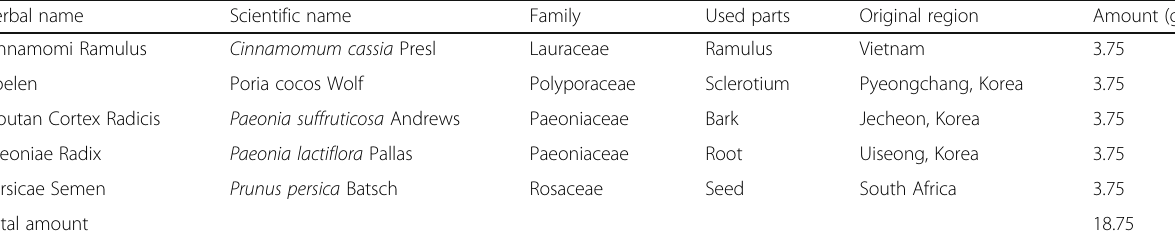
Table 1 The combination of crude components of Gyejibokryeong-hwan aqueous extract